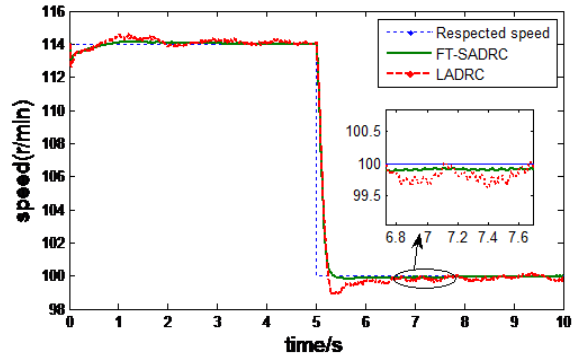
Fig. 4 Curve for the diesel engine speed y .